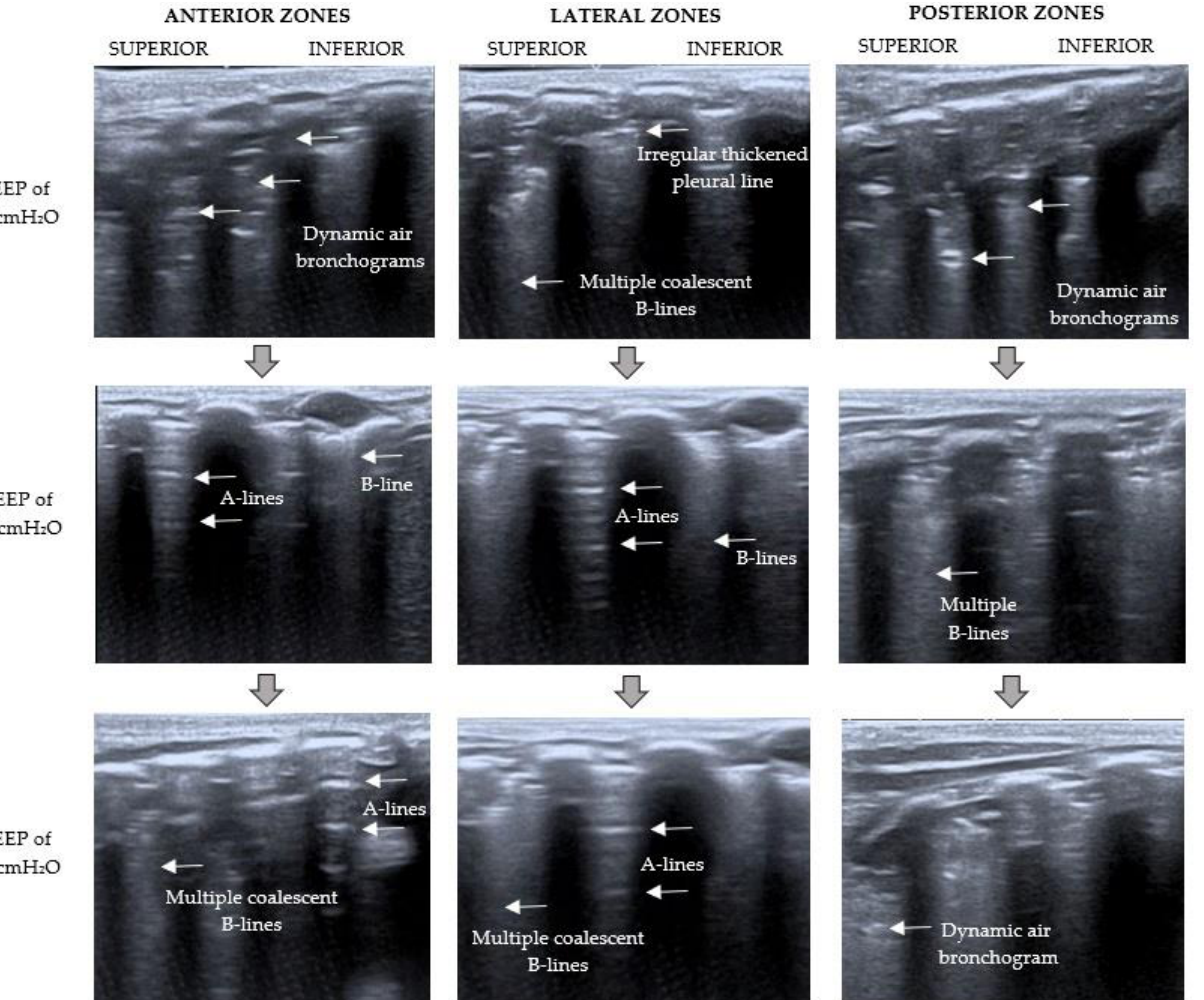
Figure 3. Left LUS examination during RMs. The point where the LUS probe is applied is indicated at the top of the figure; on the left, the PEEP level at that moment is specified. Baseline LUS (PEEP of 10 cmH 2 O) showed a C pattern (severe loss of aeration with dynamic air bronchograms). With a PEEP of 30 cmH 2 O, the pattern changed from C to B1 (moderate loss of lung aeration with multiple well-defined B-lines and some A-lines). After RMs (PEEP of 14 cmH 2 O), LUS showed a severe loss of lung aeration with multiple coalescent B-lines but some A-lines in the anterior and lateral zones (B2